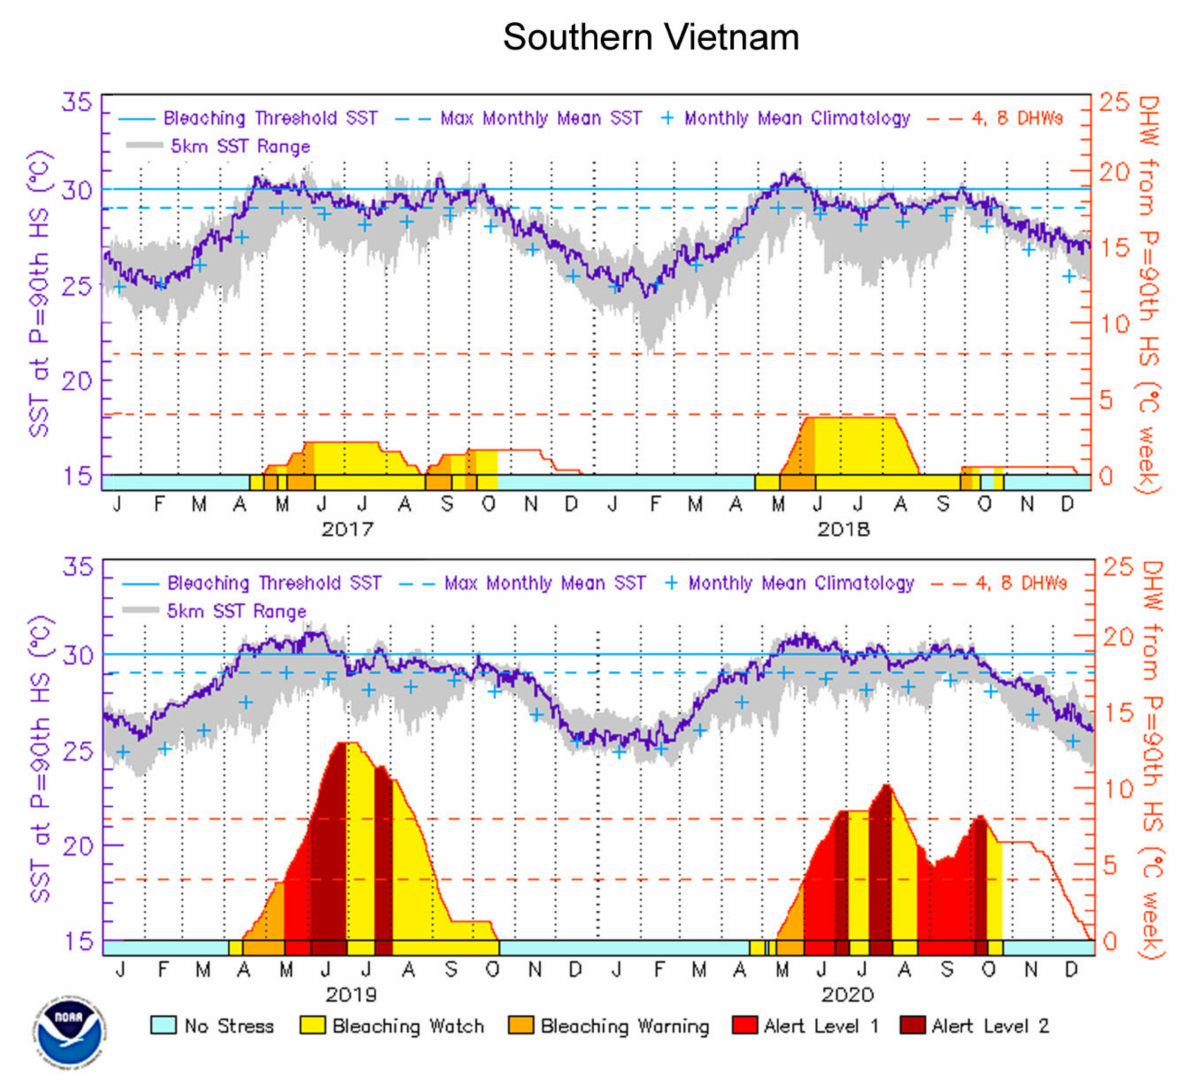
Figure 2. Sea surface temperature (SST) dynamics ( ◦ C) and degree heating weeks (DHWs, ◦ C a week) offshore southern Vietnam (from 8 ◦ 38 (cid:48) N to 13 ◦ 45 (cid:48) N) in the study period (2017–2020) according to NOAA Coral Reef Watch time series data (https://coralreefwatch.noaa.gov/product/vs/timeseries/ east_asia.php#southern_vietnam), last accessed 20 November